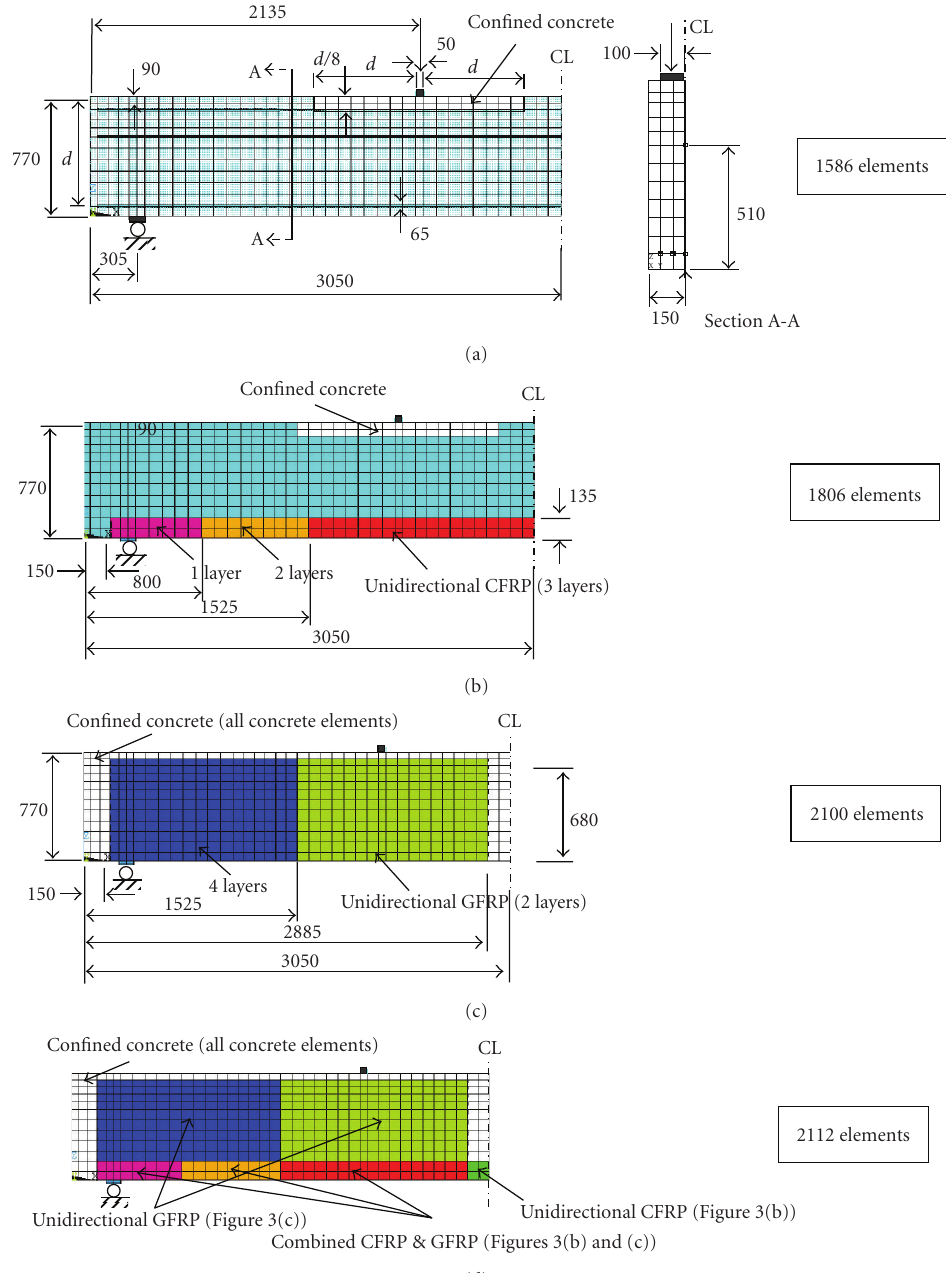
Figure 3: Finite element models (dimensions shown in mm). (a) Unstrengthened beam; (b) flexural-strengthened beam; (c) shear- strengthened beam; (d) flexural plus shear-strengthened